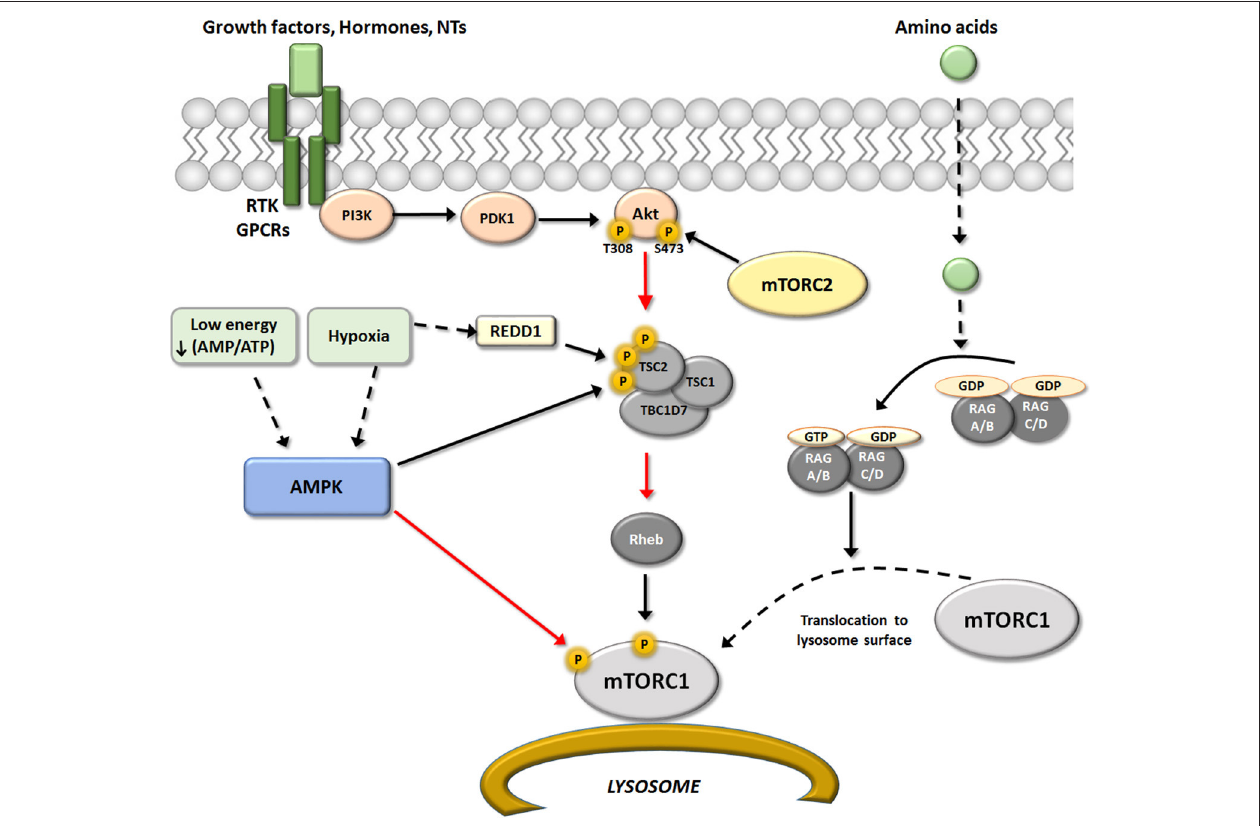
FIGURE 2 | Upstream regulators of mTORC1. Schematic representation of the different upstream pathways of mTORC1. The canonical pathway regulated mTORC1 activity through RTK/GPCRs receptors via modulation of PI3K/PDK1/Akt/TSC/Reb. This pathway may be positively regulated by growth factors, hormones and some neurotransmitters, and negatively regulated by AMPK. AMPK is activated in situations of low energy and/or hypoxia resulting in an inhibition of mTORC1 activity that may occurs at two levels. One by direct Raptor phosphorylation, that result in an inhibition of mTOR activity (red arrow); and second modifying TSC/REDD1 complex by phosphorylation. In addition, amino acids levels could modulated mTORC1 activity directly at the lysosome surface (an important place for activation of mTORC1) by modulation of heterodimers Rag A-D. Black arrows represent activation and red arrows represent inhibition.